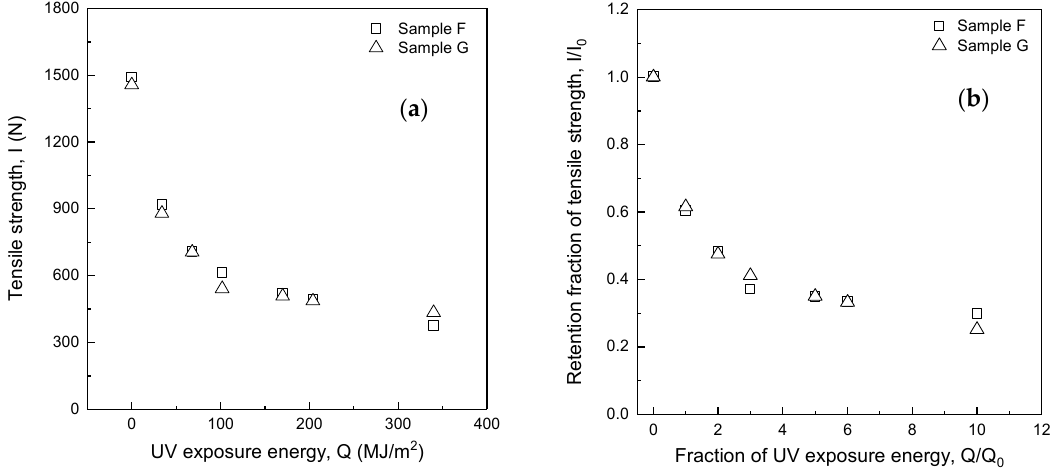
Figure 4. Tensile strength change ( a ) and retention fraction of tensile strength change ( b ) due to UV exposure with and without water repellency (m-Aramid 90%/ p-Aramid 10%).